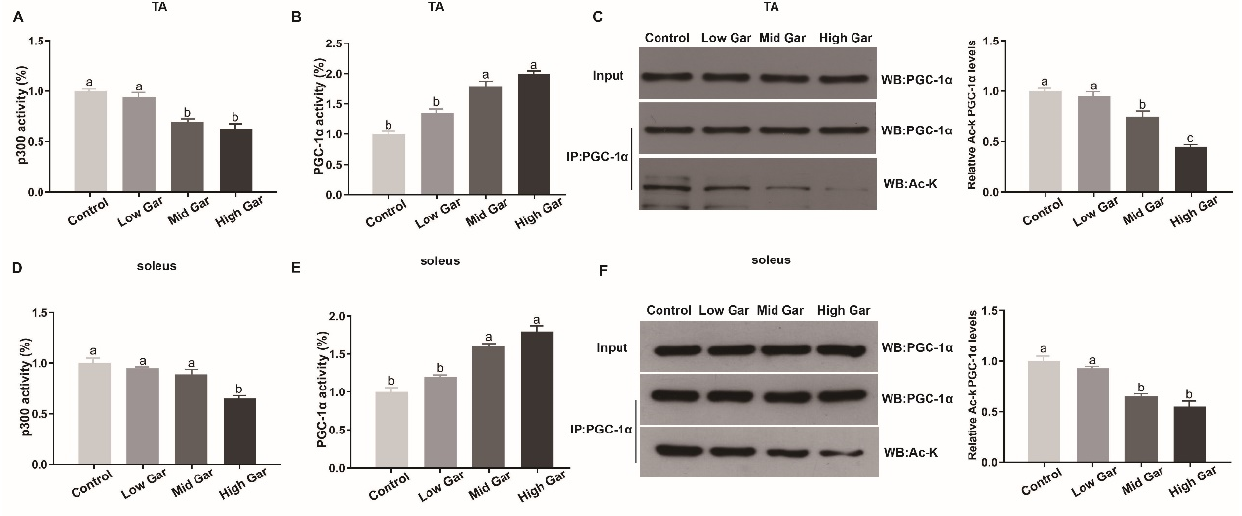
Figure 3. Effects of dietary garcinol on the activity of p300 ( A ), PGC ‐ 1 α ( B ), acetylation level of PGC ‐ 1 α ( C ) in TA muscle and the activity of p300 ( D ), PGC ‐ 1 α ( E ), acetylation level of PGC ‐ 1 α ( F ) in soleus muscle fed 0–500 mg/kg garcinol for 12 weeks. Data are shown as the mean ± SE, n = 10. Means for a given protein without a common letter differ, p < 0.05.